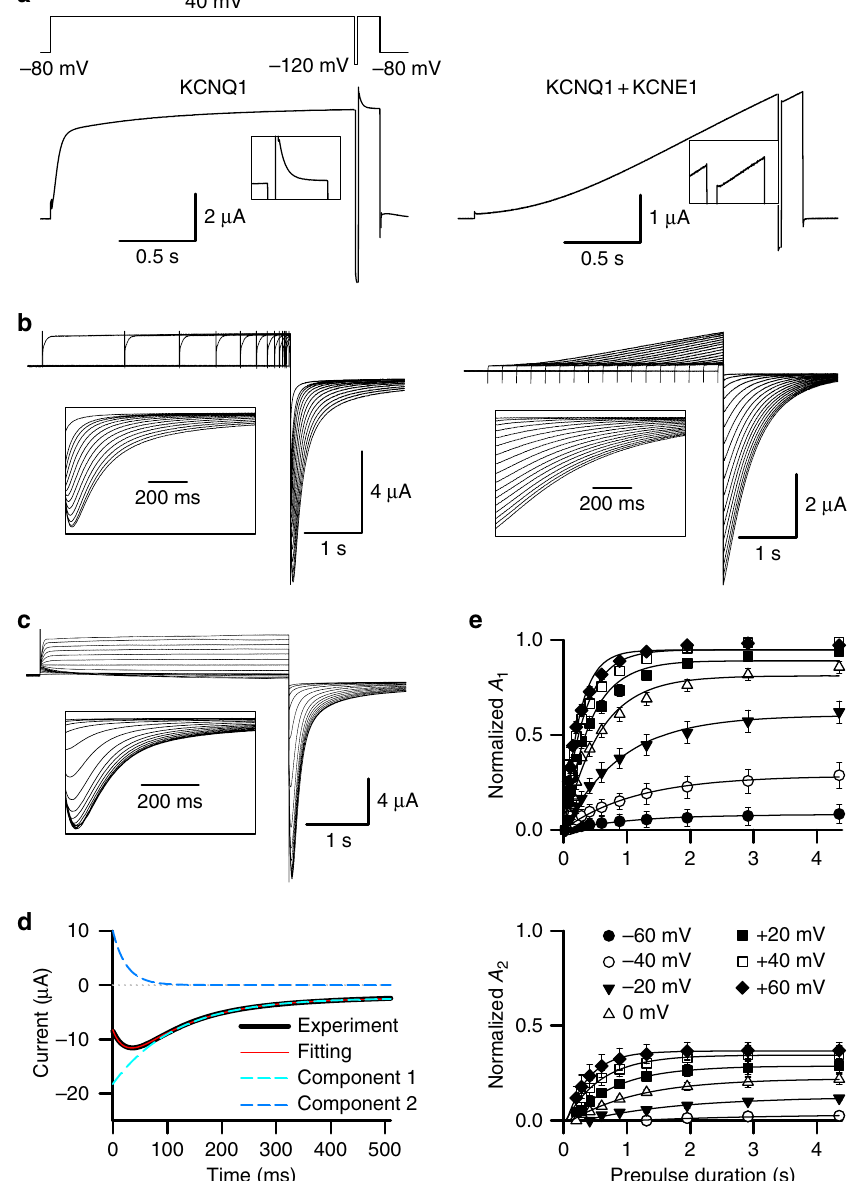
Fig. 1 Time and voltage dependence of KCNQ1 hook currents. a Left, representative KCNQ1 fast decay current recorded in ND96 solution from a triple pulse protocol. The hyperpolarizing pulse was for 20 ms at − 120 mV, and the depolarizing pulse was to +40 mV. The inset shows the fast decaying currents in response to the return of the voltage to +40 mV after hyperpolarization, with expanded current and time scales. Right, representative KCNQ1 + KCNE1 current recorded under the same conditions. b Left, time dependence of KCNQ1 hook currents recorded in high potassium (100 mM K + ) solution. The pre-pulses were +40 mV with time durations ranging between 0.02 and 4.355 s, and the test pulse was 2 s long at − 120 mV. The inset shows the hook in tail currents with an expanded time scale. Right, representative KCNQ1 + KCNE1 current recorded under the same conditions. c Voltage dependence of KCNQ1 hook currents recorded in high potassium (100 K + ) solution. The pre-pulse was 4 s with voltages ranging from − 80 to +60 mV, and the test pulse was 2 s at − 120 mV. The inset shows tail currents with an expanded time scale. d KCNQ1 hook current (black) fi tted with the double exponential function F red, cyan, and blue, respectively. e Normalized A 1 (top) and A 2 (bottom) of KCNQ1 hook currents vs. time durations of the pre-pulse, with voltages ranging from − 60 to +60 mV ( n ≥ 4). Error bars are